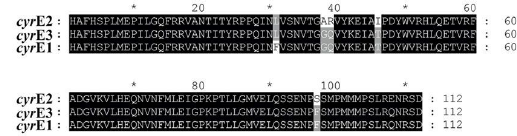
Figure 2. Alignment of cyrE sequences translated into amino